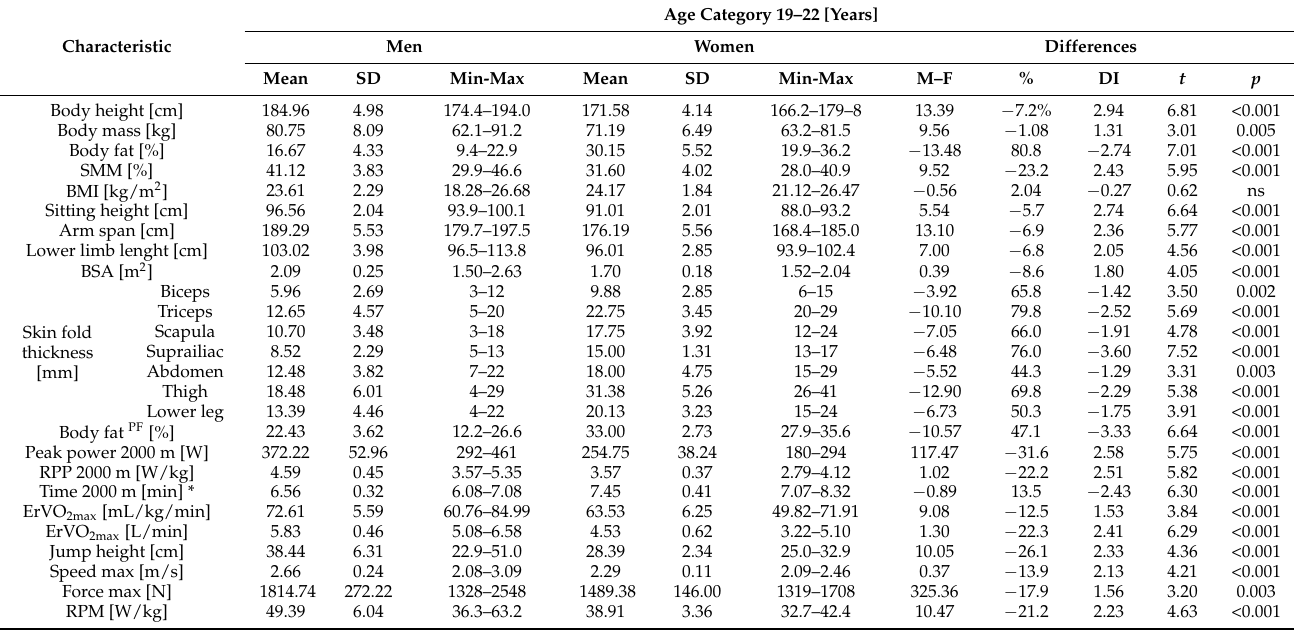
Table 3. Sexual dimorphism of anthropometric, physiological, and motor characteristics in rowers aged 19–22 years and statistical significance of